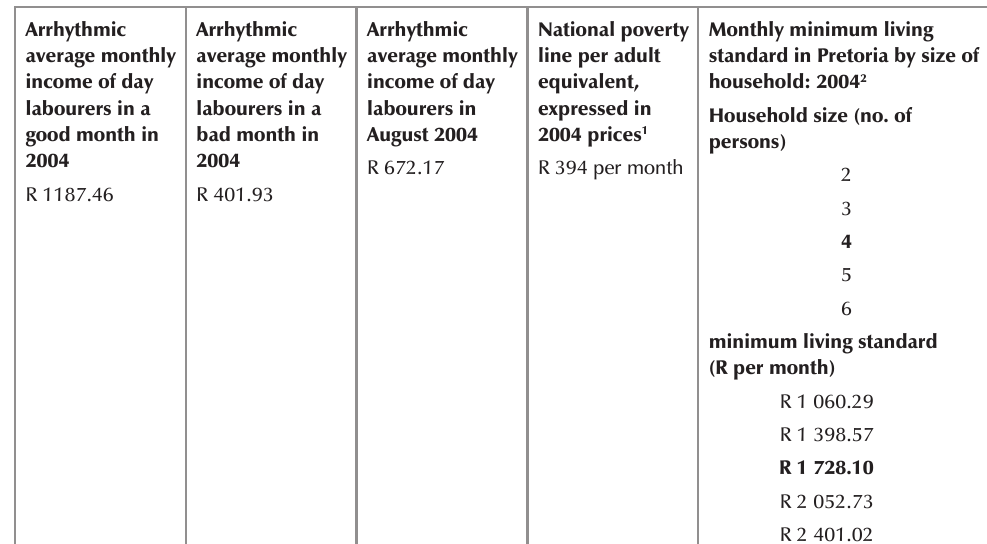
Average monthly income of day labourers compared to the sustainable living standard of monthly income in South Africa and